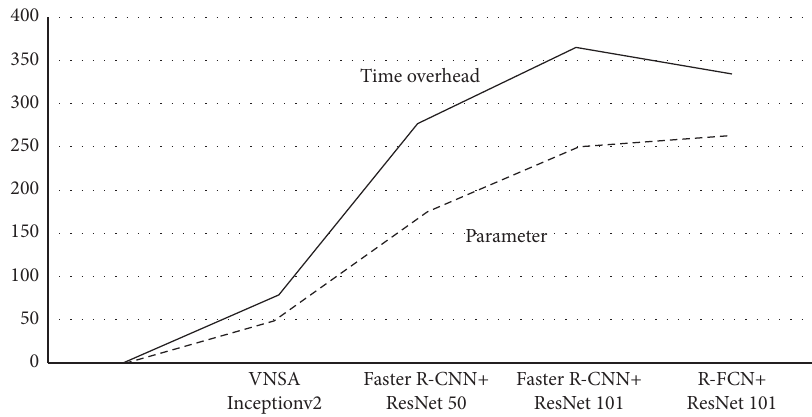
Figure 5: Comparison of calculation time and accuracy on the verification set.